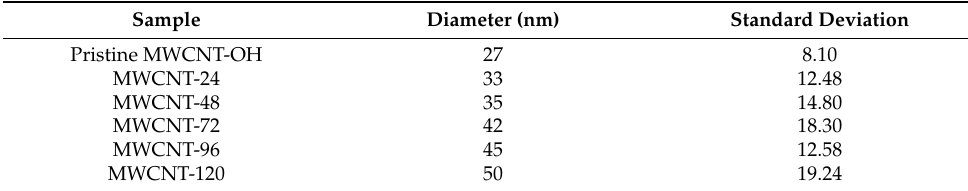
Table 3. Mean diameter of P3HT/MWCNT-OH nanocomposites at different reaction times.